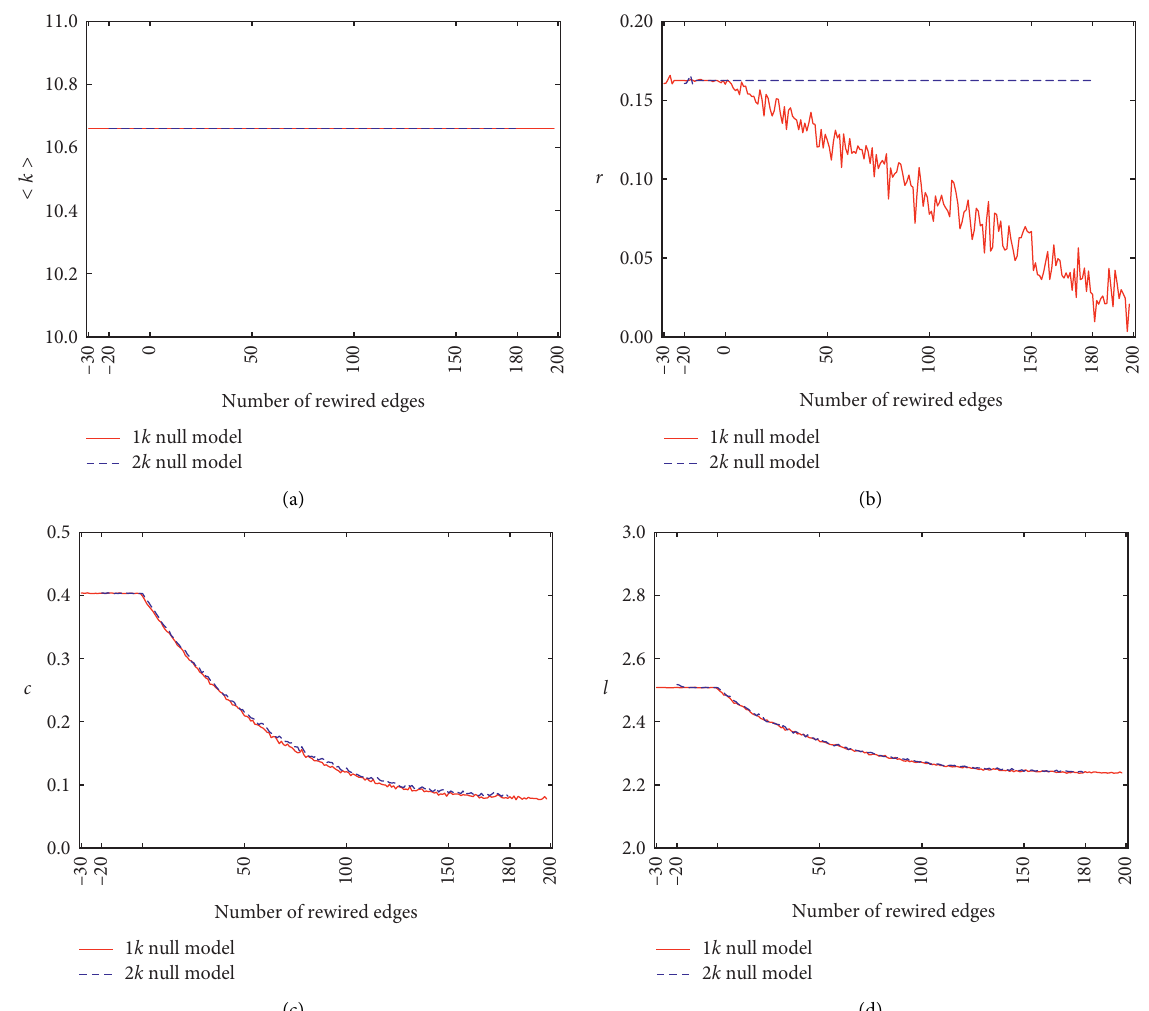
Figure 6: Structural characteristic of the benchmarks generated based on the football network, including average degree < k > , assortativity coefficient r , clustering coefficient c , and average shortest path length l . Red lines correspond to the benchmarks generated based on the 1 k null model, and blue lines correspond to the benchmarks generated based on the 2 k null model. The negative and positive values of the abscissa represent the number of rewired edges when the community structure is strengthened and weakened,